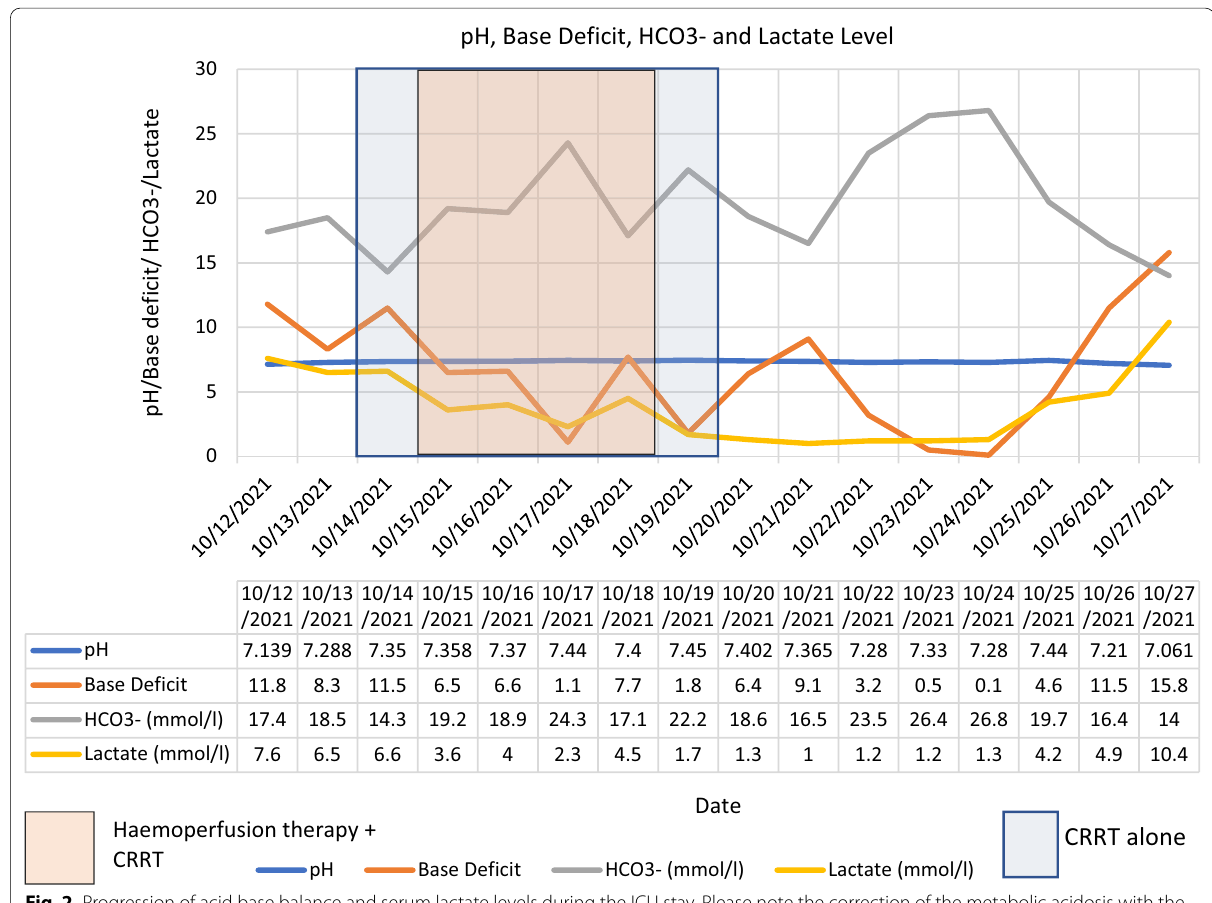
Fig. 2 Progression of acid base balance and serum lactate levels during the ICU stay. Please note the correction of the metabolic acidosis with the use of CRRT and its reappearance after discontinuation of CRRT. Subsequently, the acidosis got corrected along with organ recovery until fungal sepsis